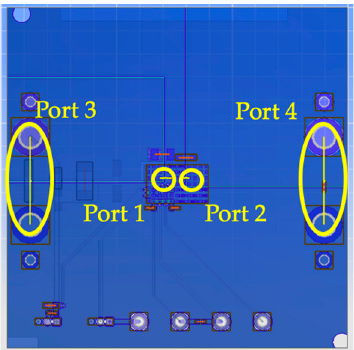
Figure 12. Port definitions of DC1379B. Table 1. Parameter settings of each port.